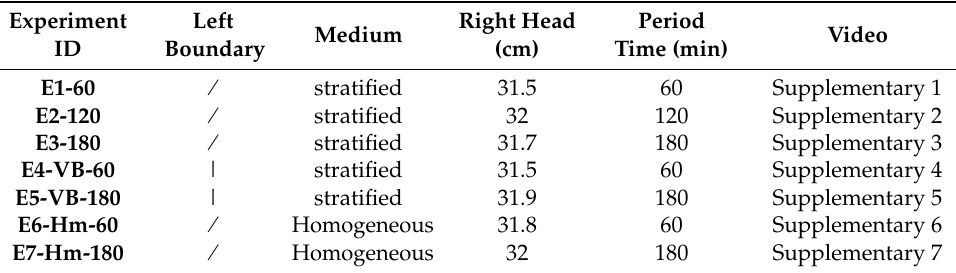
Table 1. The experiments details. At the experiment’s ID, VB is Vertical Boundary and Hm is homogeneous. The number in each name represents the duration, in minutes, of the tide period. / and | describe oblique and vertical left boundary, respectively.